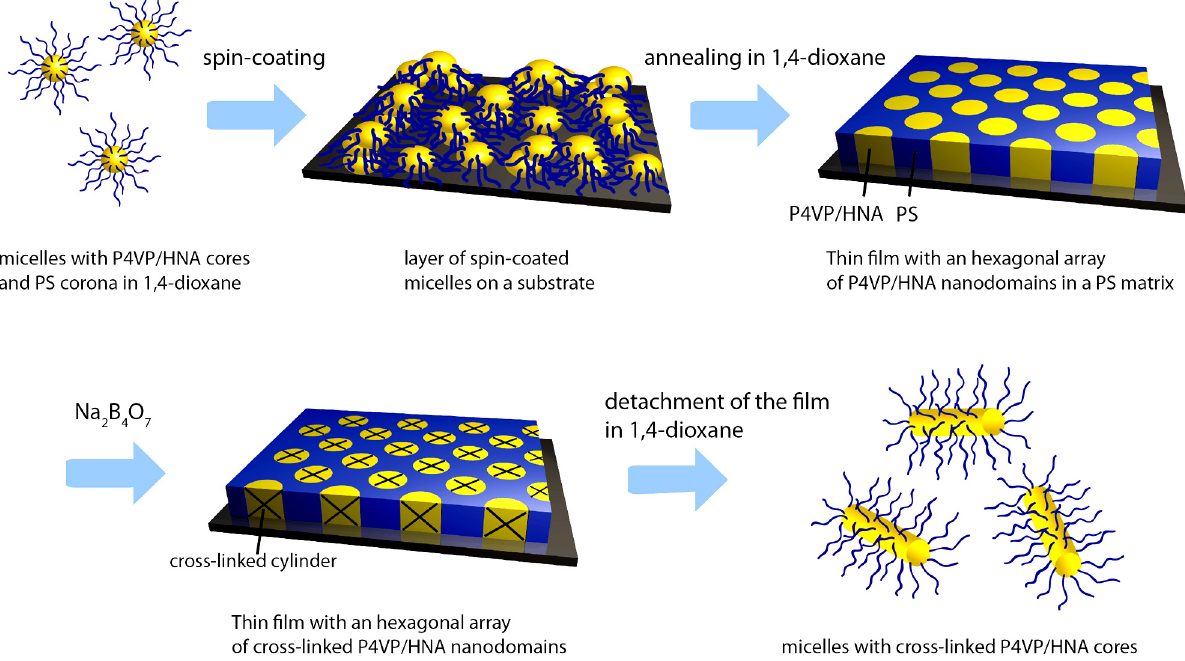
Figure 6 . AFM height and phase images for a nanoporous thin film prepared from the PS- b -P4VP/HNA mixture (4VP/HNA 1:1 molar ratio) at 1 wt % in 1,4-dioxane,